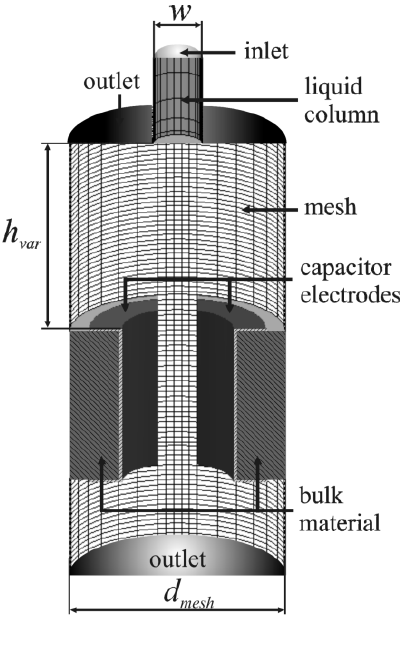
Figure 3. Computational domain as used for the CFD